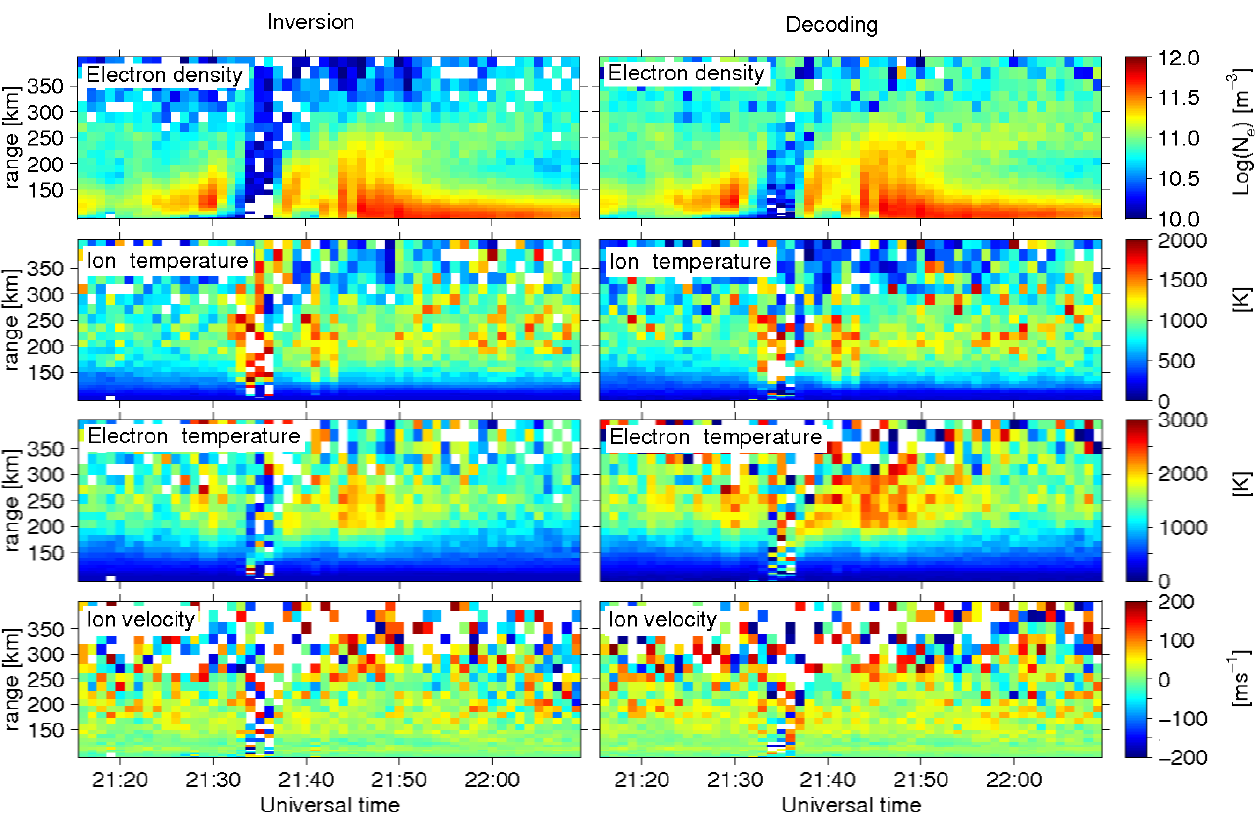
Fig. 6. Fitted plasma parameters by means of the inversion method and standard decoding with GUISDAP. The time period is from 2 October